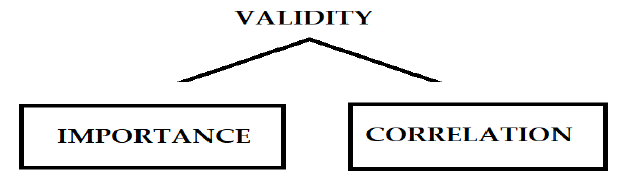
Fig. 8. There is a distinction between the concept of importance and correlation in neutrosophic